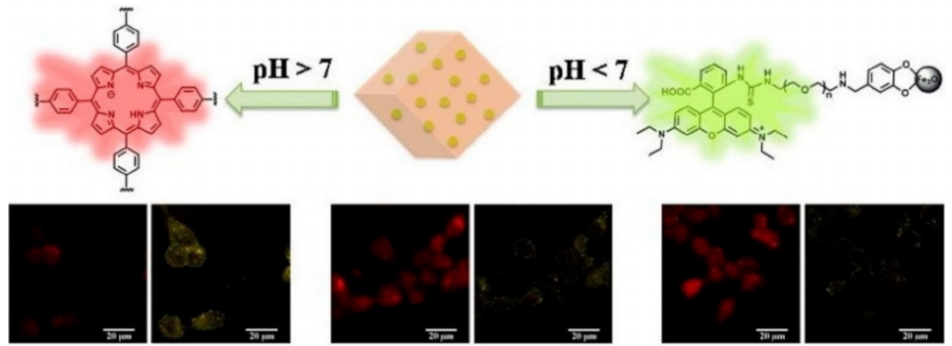
Figure 4. Schematic illustration of the dual-emission fluorescent MOF for monitoring the change of pH value with an excitation wavelength. Reproduced with permission [88]. Copyright 2018, American Chemical